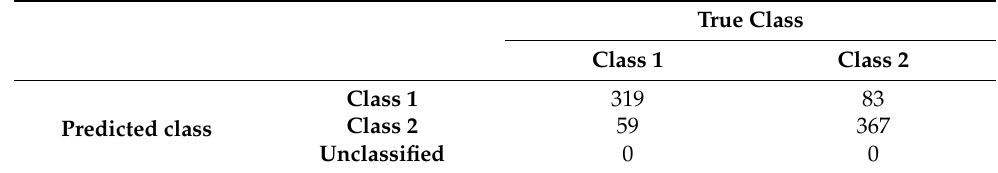
Table 11. Total confusion matrix of 10-fold cross-validation of classification results with the DNRS with 90 samples of training data using attributes 4, 6, and 7 of the Raisin dataset.